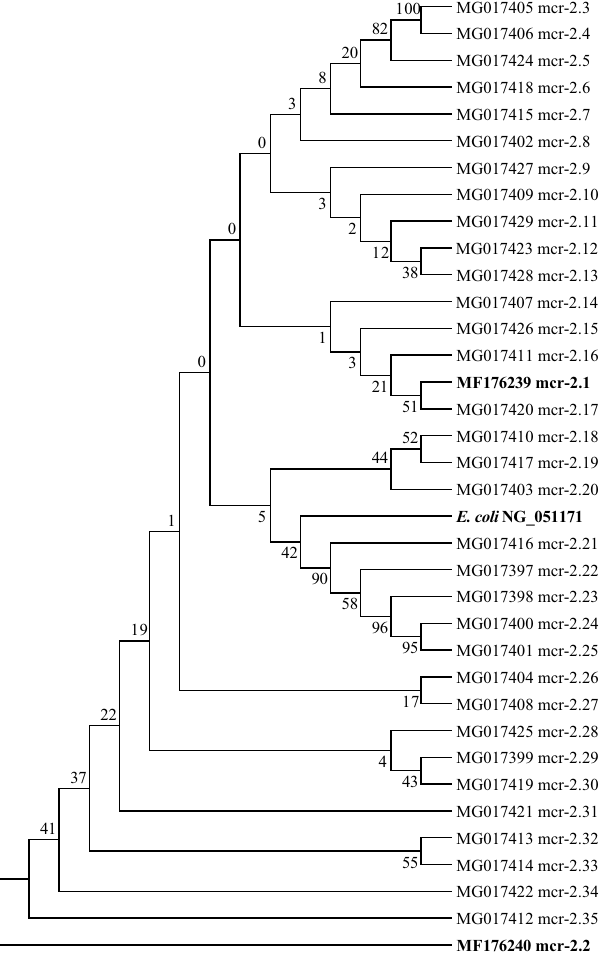
Figure 4. Phylogenetic analysis of colistin resistance gene mcr-2 . The nucleotide sequences of mcr-2 gene (1,042-bp) identified in this study are compared with representative sequences from NCBI (in bold font) using the Neighbor-Joining method. The optimal tree with the sum of branch length (0.419) is shown. The percentage of replicate trees in which the associated taxa clustered together in the bootstrap test (500 replicates) are shown next to the branches. The evolutionary distances were computed using the Kimura 2-parameter method and are in the units of the number of base substitutions per site. All positions containing gaps and missing data were eliminated. Evolutionary analyses were conducted in